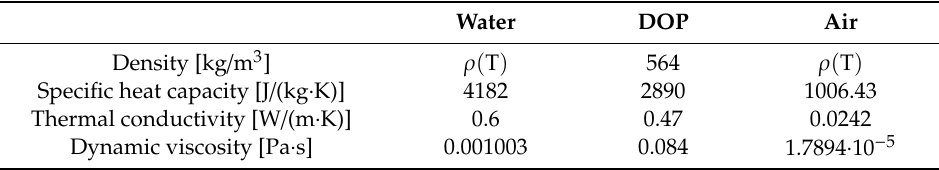
Table 3. Main physical properties of the multiphase flow inside the batch